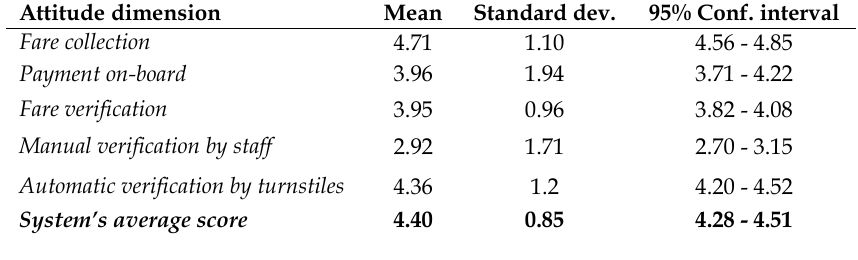
Dimensional average of attitudinal scores on a scale of 1 to